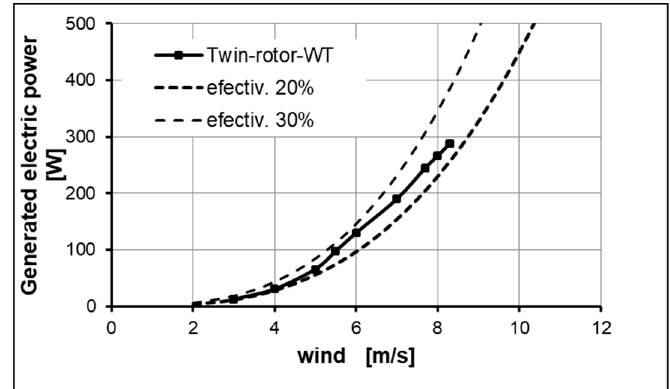
Figure 16. Power generation by the Twin-rotor wind turbine prototype.